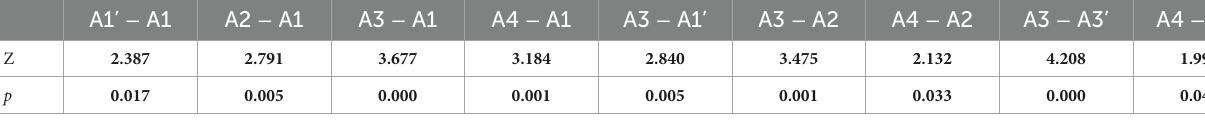
TABLE 9 Wilcoxon ranked sign test for the fixation duration (only for p < 0.05).